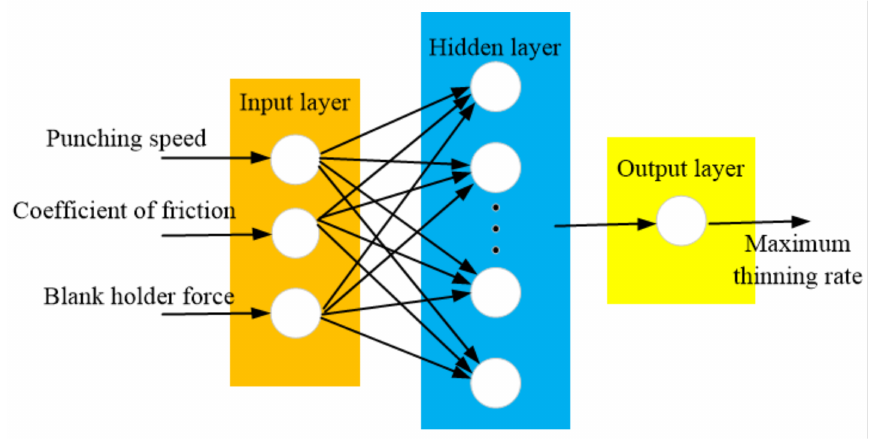
Figure 16. BP neural network